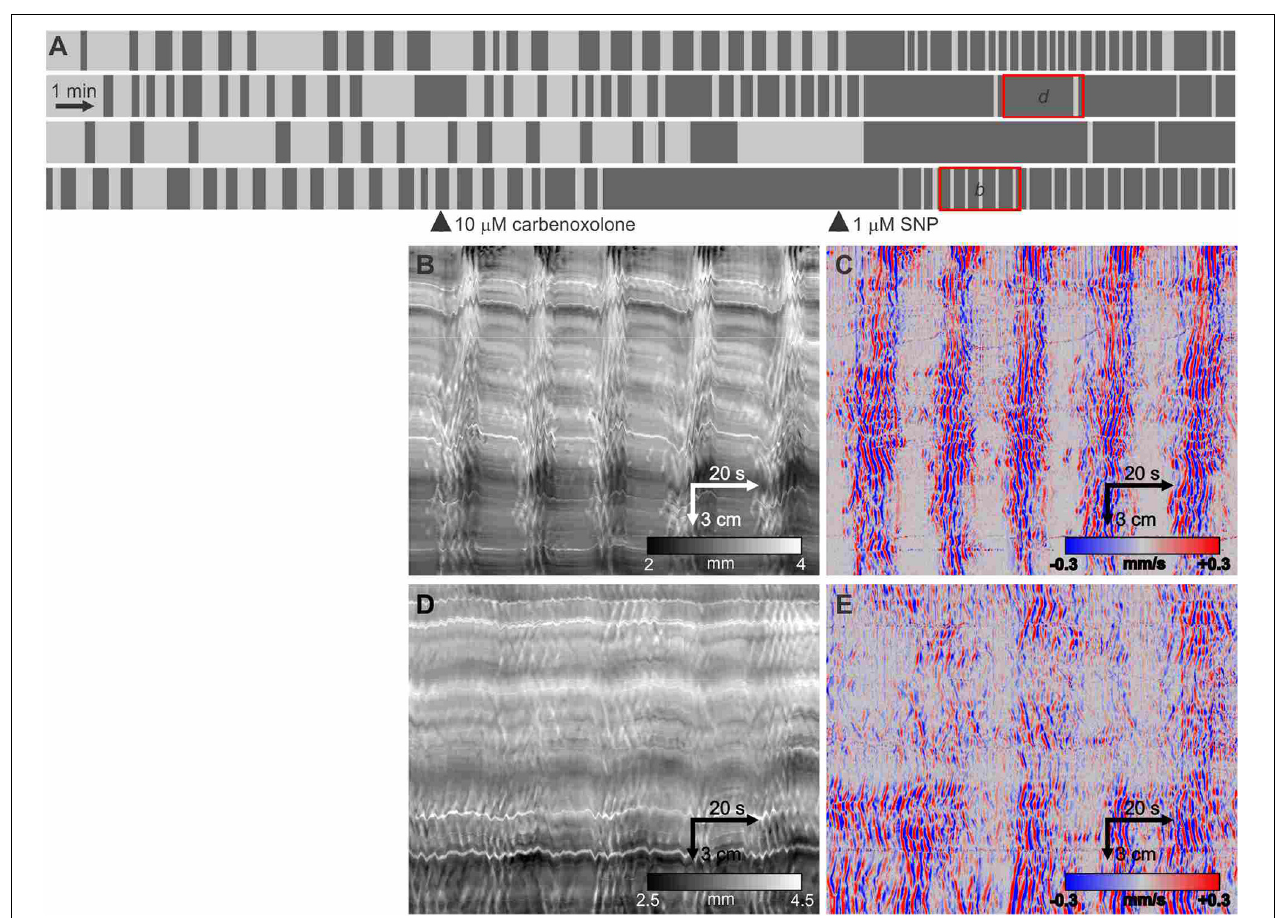
FIGURE 7 | Effect of carbenoxolone and subsequent SNP. (A) Telegraph images of four intestines showing effect of 10 µ M carbenoxolone followed by the addition of 1 µ M SNP. All the short clusters after the addition of SNP are markedly weaker in strength of circular muscle contraction but have a strong longitudinal contraction (B) . (B,D) DMaps from the intestines as indicated in panel (A) . (C,E) are the respective DMaps processed as outlined in Figure 1 . Within the clusters, the contraction waves are highly irregular likely due to inhibition of gap junction conductance decreasing synchronization within the ICC-MP